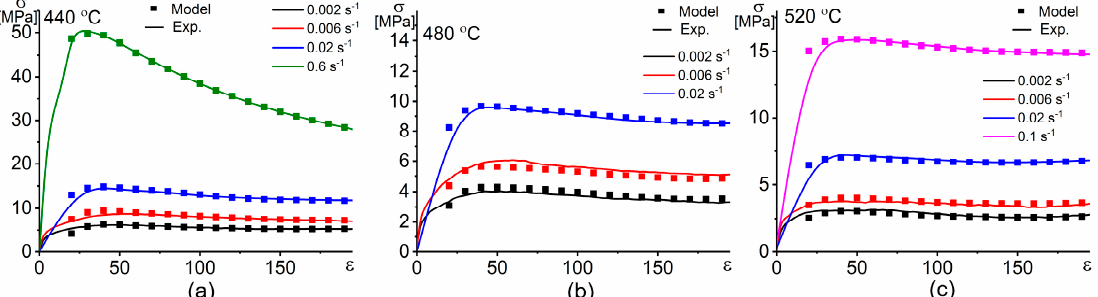
Figure 9. Dependences of the experimental and the predicted in the ANN model stresses vs. strain at different strain rates and temperatures of ( a ) 440 °C, ( b ) 480 °C, and ( c ) 520 °C.